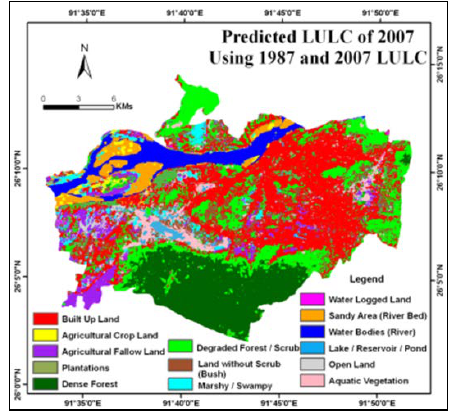
Figure 4: Predicted LULC of 2007 using 1987 & 1997 LULC image